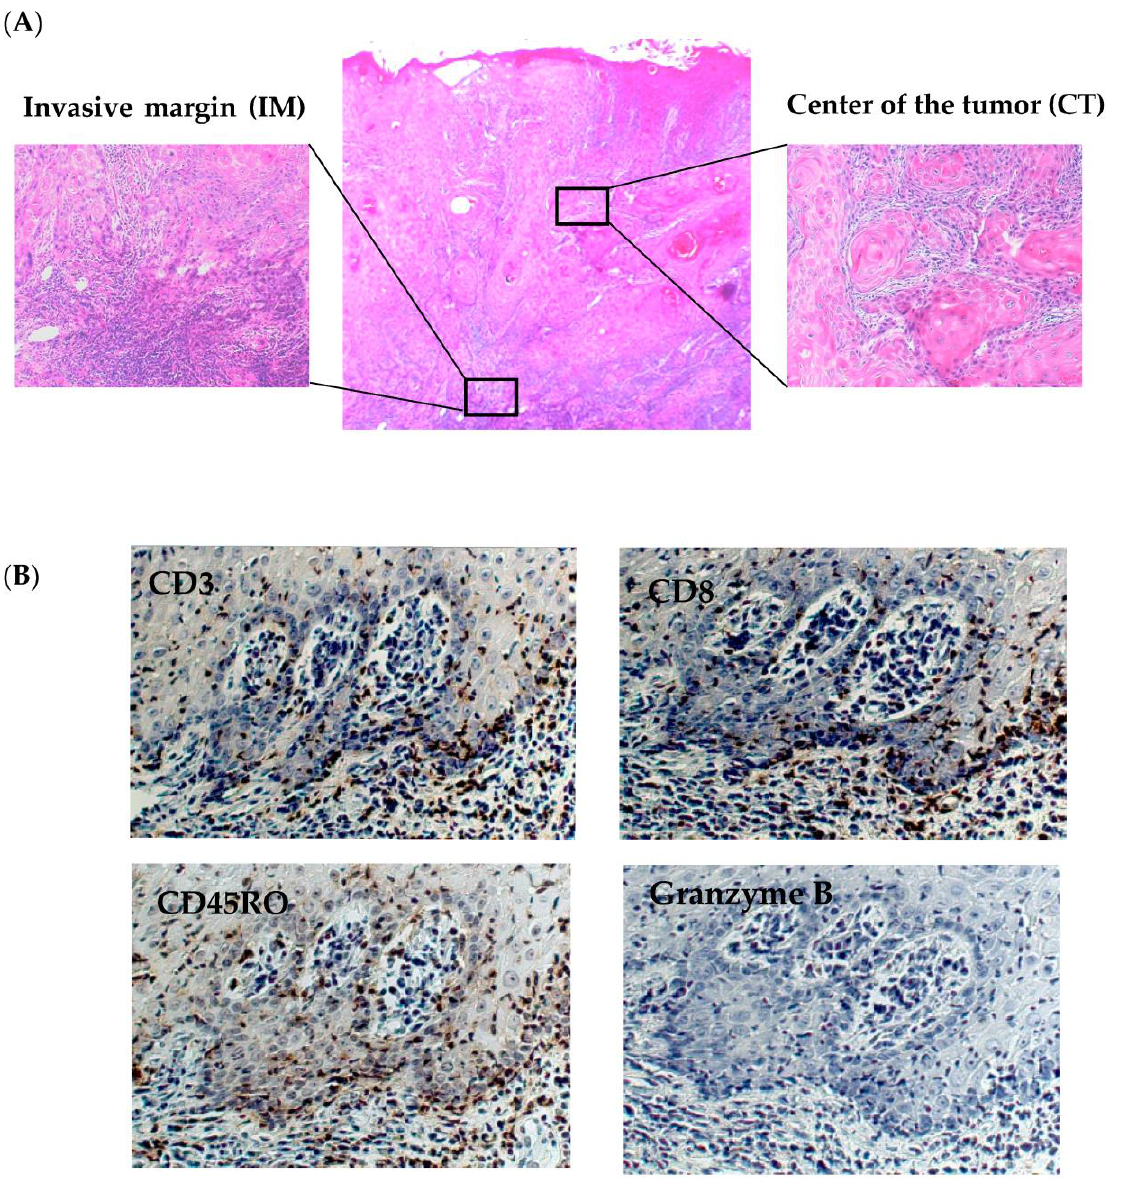
Figure 1. A standardized approach to TIL evaluation for patients with OSCC. The areas of the tumor where the number of TILs was to be measured were determined for CT and IM ( A ) (original magnification center ×40 both sides ×400). Immunohistochemistry was used to identify CD3 + , CD8 + , CD45RO + , and Granzyme B + TILs ( B ) (original magnification ×400).